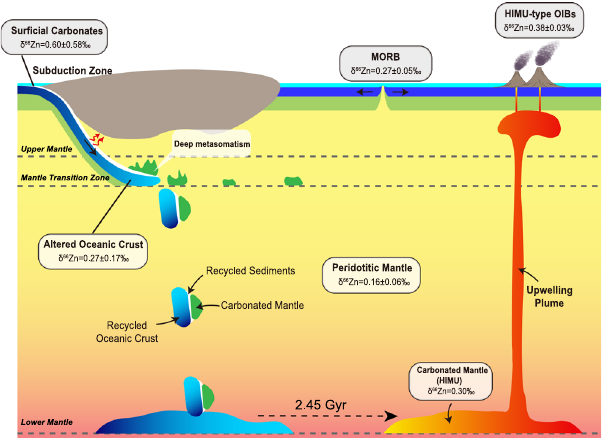
Fig.4|CartoondepictingtheproposedgenesisofHIMUcomponent. Estimated average Zn isotopic compositions for various reservoirs are also shown. The average values for MORB, altered oceanic crust and sedimentary carbonates are calculated by data measured in thisstudy and data from reference. All data source for Fig. 4 is given in Supplementary Information, Note 6. The average value for carbonated mantle is assumed in this study. Estimated δ 66 Zn value of peridotitic mantle is taken from ref. 27. MORB=Mid-Ocean Ridge Basalt; OIB=Ocean Island Basalt; HIMU=high μ ( μ = 238 U/ 204